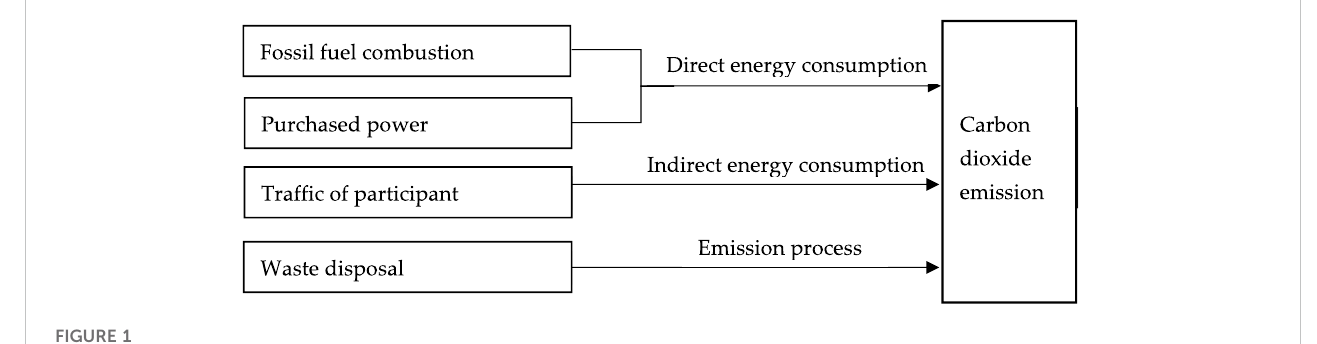
Decomposition of emission activities of auctions.